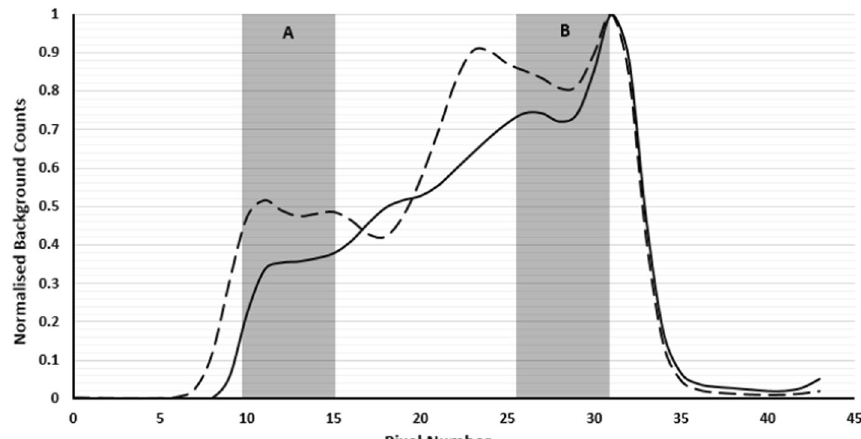
Fig. 7 Vertical profiles of two of the reconstructed Poisson‑resampled background data. Quantification using local VOI method was performed with background correction VOIs in two vertical locations indicated by the grey